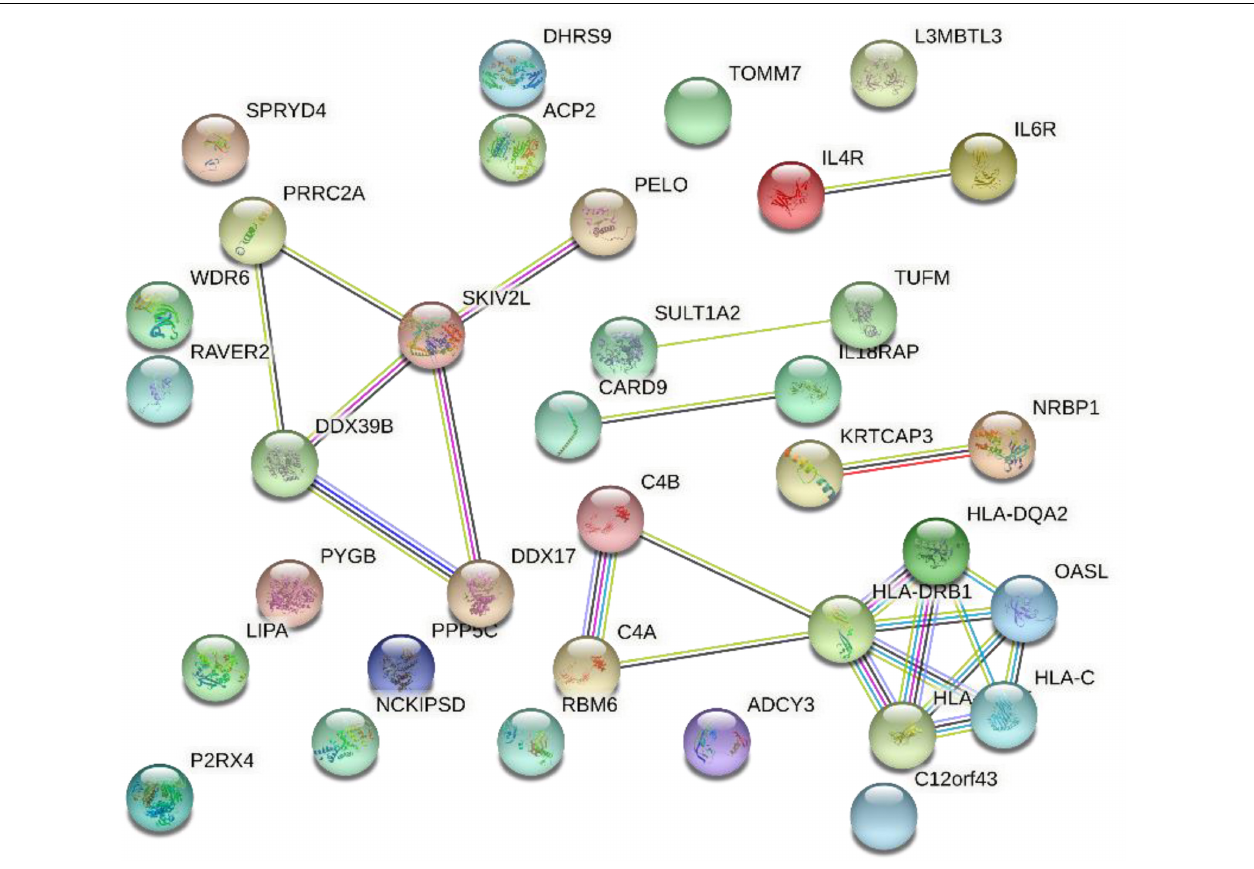
FIGURE 6 | Gene interaction network obtained from 45